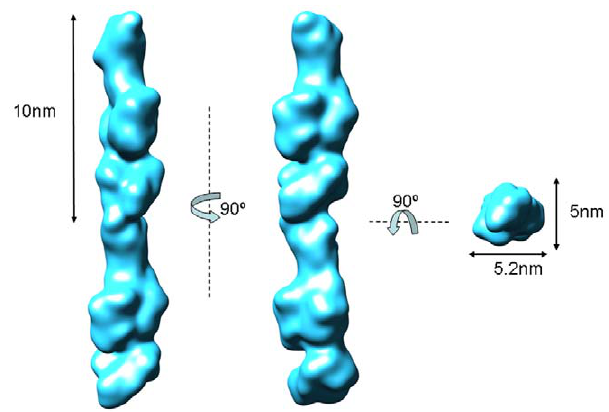
Figure 2. Three-dimensional reconstruction of the S.pneumo- niae pilus. Surface representation of the S. pneumoniae pilus viewed along three orthogonal directions. The reconstruction is rendered at the molecular mass expected for two RrgB subunits (66 kD each). Structure is viewed along three orthogonal directions. Surface representation rendered with Chimera (Pettersen EF et al 2004).